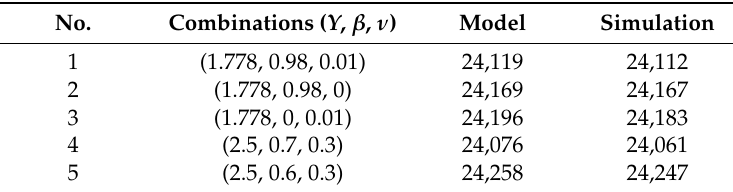
Table 3. Annual power generation (GWh) by the SLP model itself and by operation simulation with different